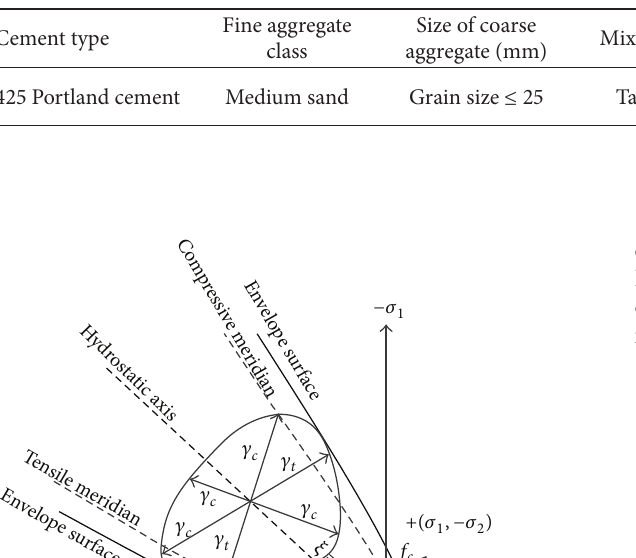
Table 3: The concrete composition and the material consumption.